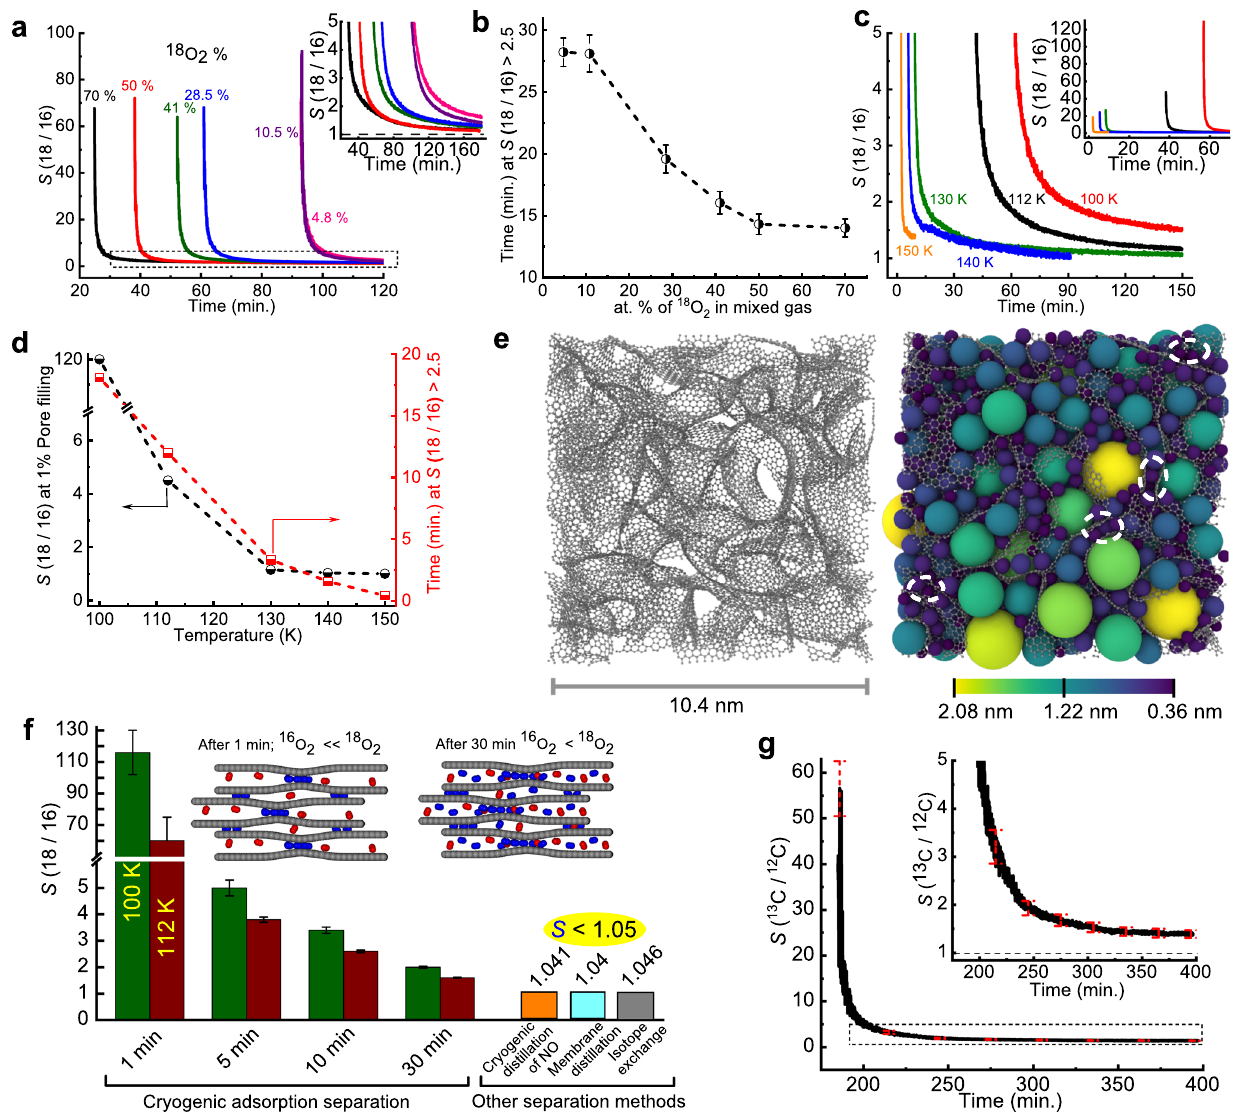
Fig. 2 Kinetic cryogenic adsorption-based selective separation of oxygen and methane isotopes using carbide-derived carbon (CDC). a S ( 18 O 2 / 16 O 2 ) (referred to hereafter as S (18/16) in the fi gures) of the CDC at 112 K for different atomic % of 18 O 2 in the feed gas mixture ( 18 O 2 + 16 O 2 ) under similar dosing rate (~1 mL min − 1 ). The percentage of 18 O 2 in the feed gas mixture varied from 4.8 at.% to 70 at.%. The inset shows an enlarged view of the dotted regions. The black dashed line represents S = 1. b Time of S > 2.5 for different percentages of 18 O 2 in the feed gas containing a mixture of the isotopes. Error bars (black lines) represent the standard deviations of three measurements. c Temperature dependence of selectivity S examined for equimolar (50 at.% S at 1% pore volume fi lling (black) and time 18 O 2 ) isotope mixtures using CDC at 100, 112, 130, 140, and 150 K. Inset shows a very high initial selectivity. d for which S > 2.5 (red) for CDC as a function of temperature. e , left: Simulated CDC structure. Gray spheres and lines represent the carbon atoms and their bonds, respectively. The snapshot shows a slice of the structure with a length of 10.4 nm and a depth of 3.5 nm. Right: 3D rendering of the same slice fi lled with nonoverlapping spheres. The spheres are colored by diameter, with the values indicated in the color bar. Dashed white ovals identify narrow pore sites fi lled with spheres of diameter <0.4 nm. f Comparison of S at different times at 100 K and 112 K for the CDC in this work with other separation methods from the literature. The inset shows illustrative models for the pore fi lling of CDC by 16 O 2 and 18 O 2 molecules after 1 min and 30 min. References correspond to cryogenic distillation (16,17), membrane distillation (18,19), and isotope exchange (20). g S ( 13 CH 4 / 12 CH 4 ) (written as S ( 13 C/ 12 C) in the − 1 ). The inset shows an enlarged view of the dotted fi gure) of CDC at 112 K for feed gas mixture ( 13 CH + 12 CH 4 4 ) under similar dosing rate (~1 mL min regions. The error bar represented by the red dashed line is the standard deviations derived from three